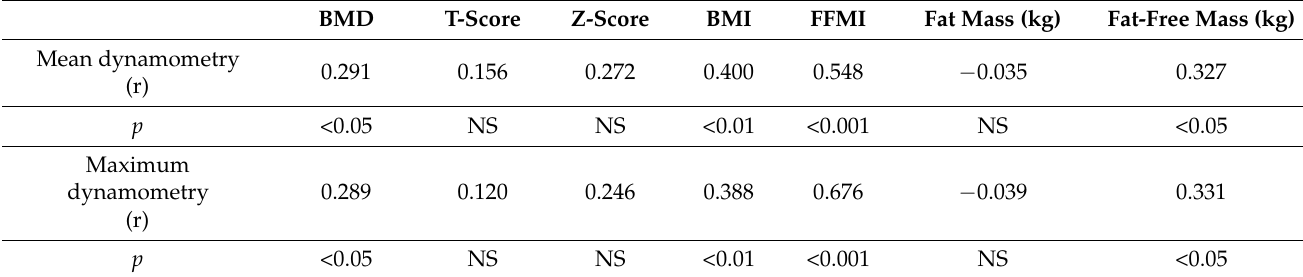
Table 3. Correlations between muscle strength and nutritional and bone